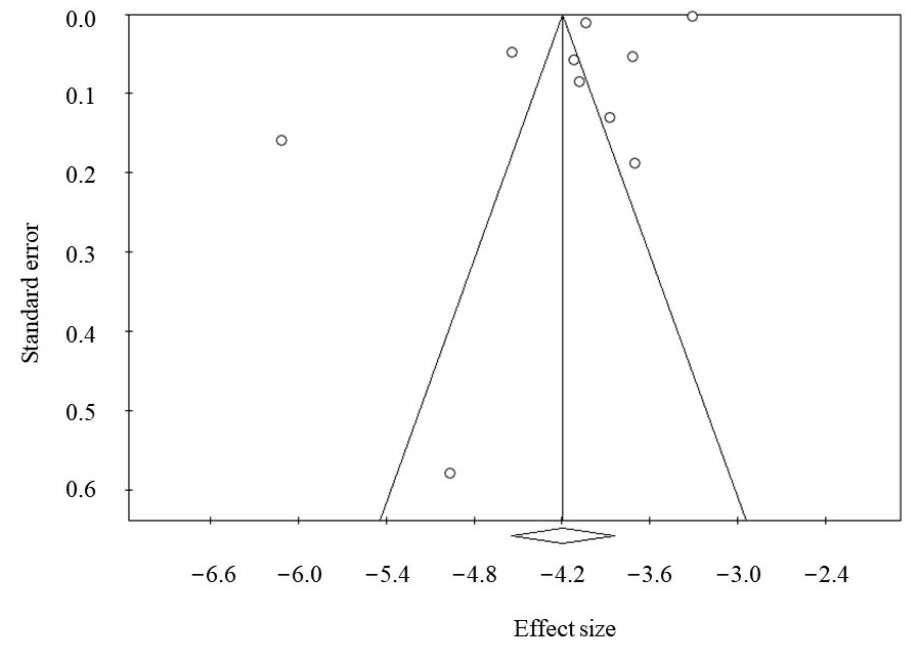
Figure 4. Funnel plot of publication bias (Egger’s test: p = 0.086; Begg and Mazumdar’s test: p = 0.245).